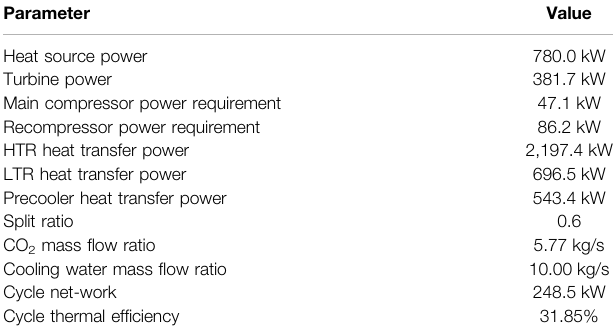
TABLE 2 | Detailed condition of the steady state. Parameter Value Heat source